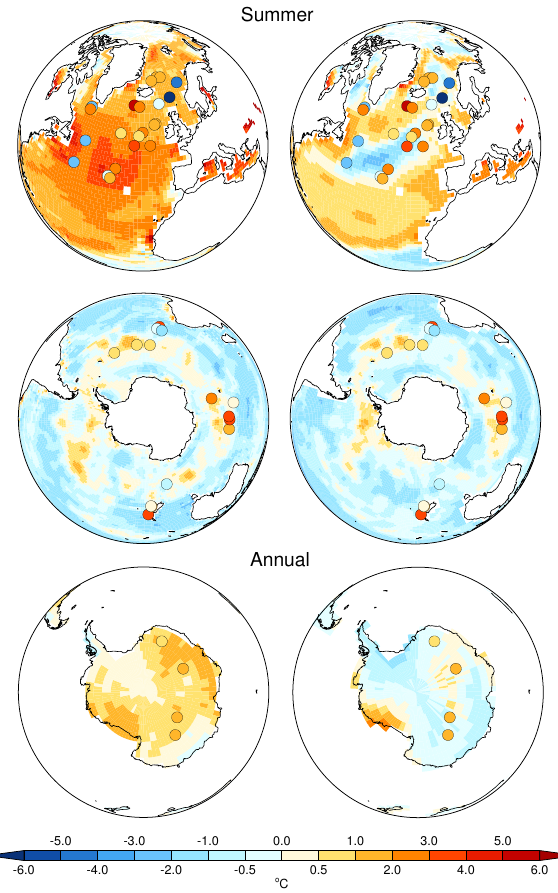
Figure 6. Simulated summer (NH July, August, September; SH January, February, March) SST and annual (bottom panel) surface air temperature anomalies at 125ka compared with the Capron et al. (2014) 125ka data-based time slice. Left panel: HadCM3; right panel: NorESM. Table 2 shows a similar agreement with data for NorESM and HadCM3 (which has no cooling in the North Atlantic) in the NH when compared with the 125ka data-based time slice from Capron et al. (2014). However, NorESM shows poor agree- ment with the data synthesis over Antarctica. Anomalies calculated relative to the modern period for both the model and the